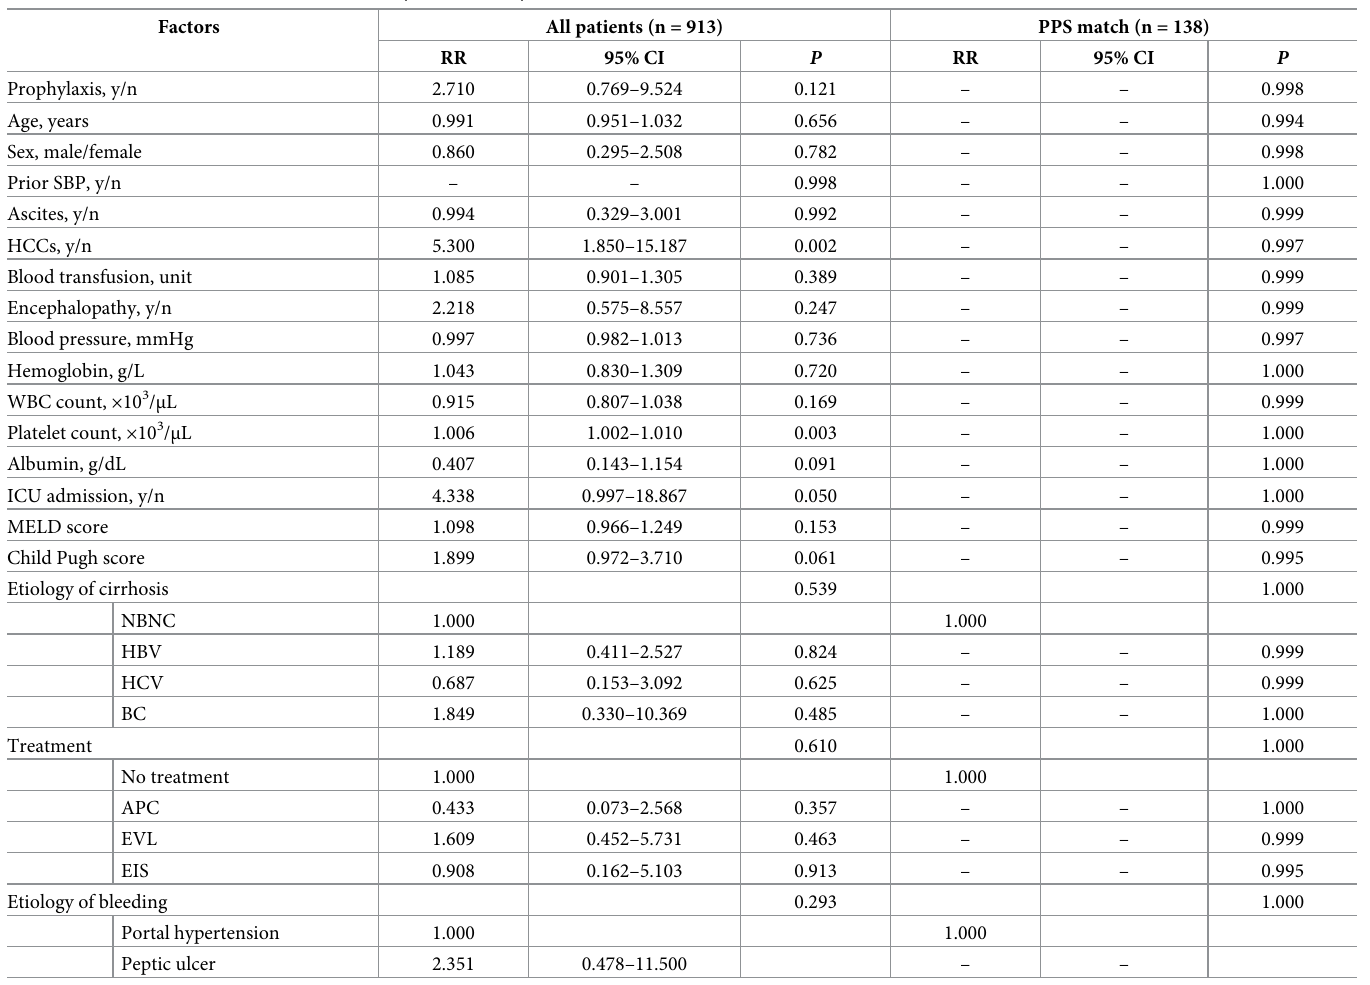
Table 6. Factors associated with risk of mortality within 42 days †